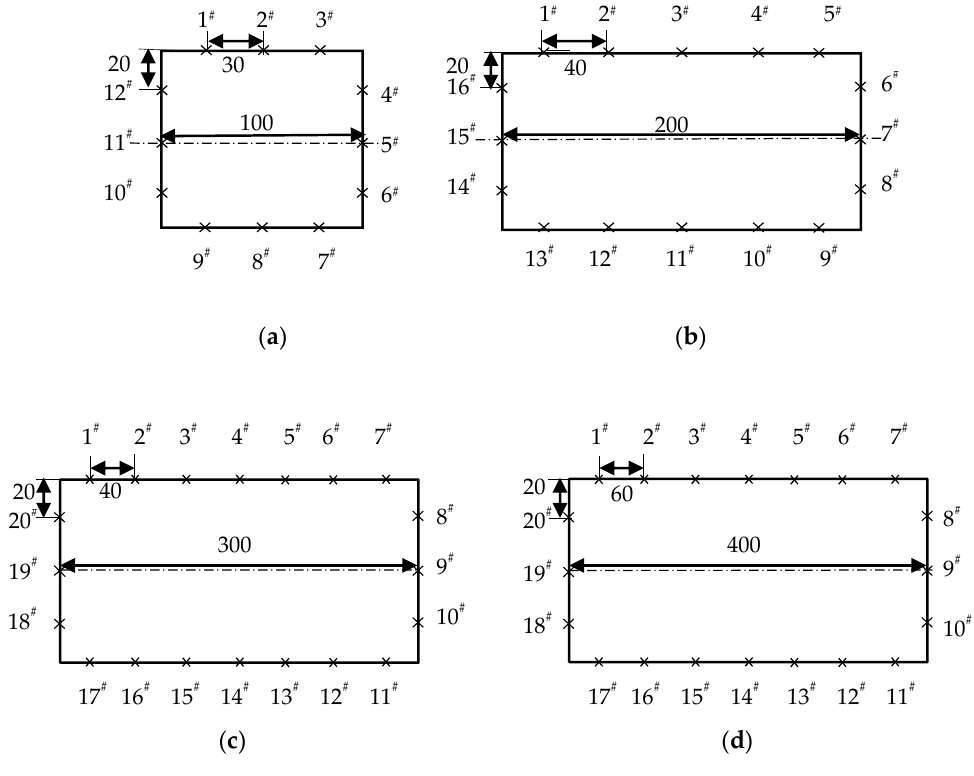
Figure 3. Layout of pressure measurement points: ( a ) 100 × 100; ( b ) 200 × 100; ( c ) 300 × 100; ( d ) 400 × 100 (mm). Table 1. Experimental parameters.